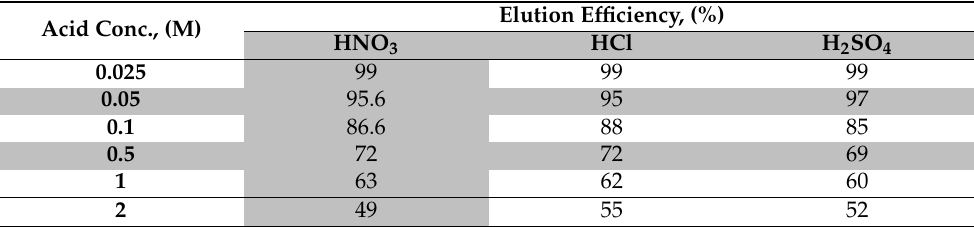
Table 4. Effect of eluting agent’s concentration on zirconium ions elution from PPVP/Zr. Acid Conc.,